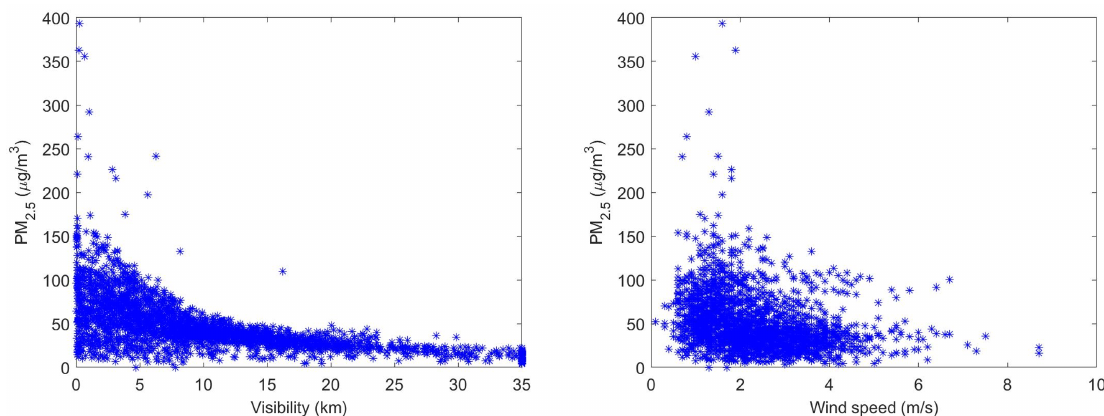
6 of 18 Table 1. Pearson’s linear correlation coefficient between PM 2.5 and meteorological parameters. visibility